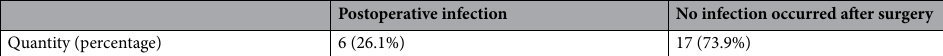
Table 6. The relationship between postoperative wound infection and secondary penile epidermoid